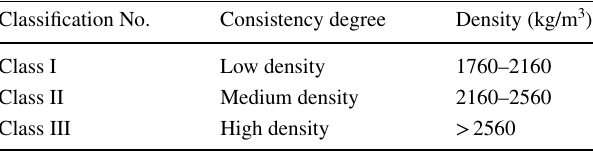
Table 3 Standard specification for limestone dimension stone as in